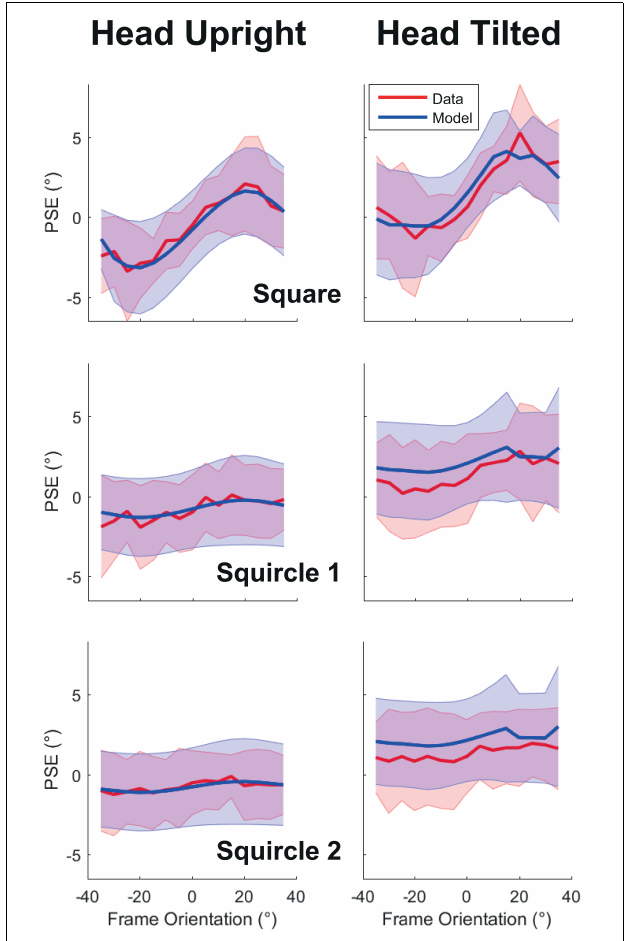
FIGURE 3 | Point-of-subjective equality as a function of frame orientation. Panels on the left correspond to the head upright condition, to the right to the head tilted condition. The panels from top to bottom correspond to the used frame forms: square, squircle 1, and squircle 2. Grand averages are plotted as lines, standard deviation over participants as shaded regions. In red the observed data, in blue the results of the best-fit model. PSE, point-of-subjective equality.